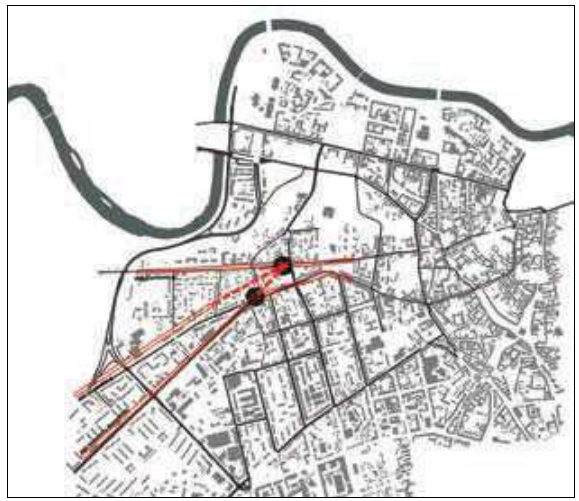
2 pav. L. Gucevičiaus projekto schema dabartiniame Vilniaus m. plane (schema autorės) Fig. 2. Scheme of L. Gucevičius’ project in the present Vilnius plan (author’s scheme) Fig. 3. Project of straight streets in front of the